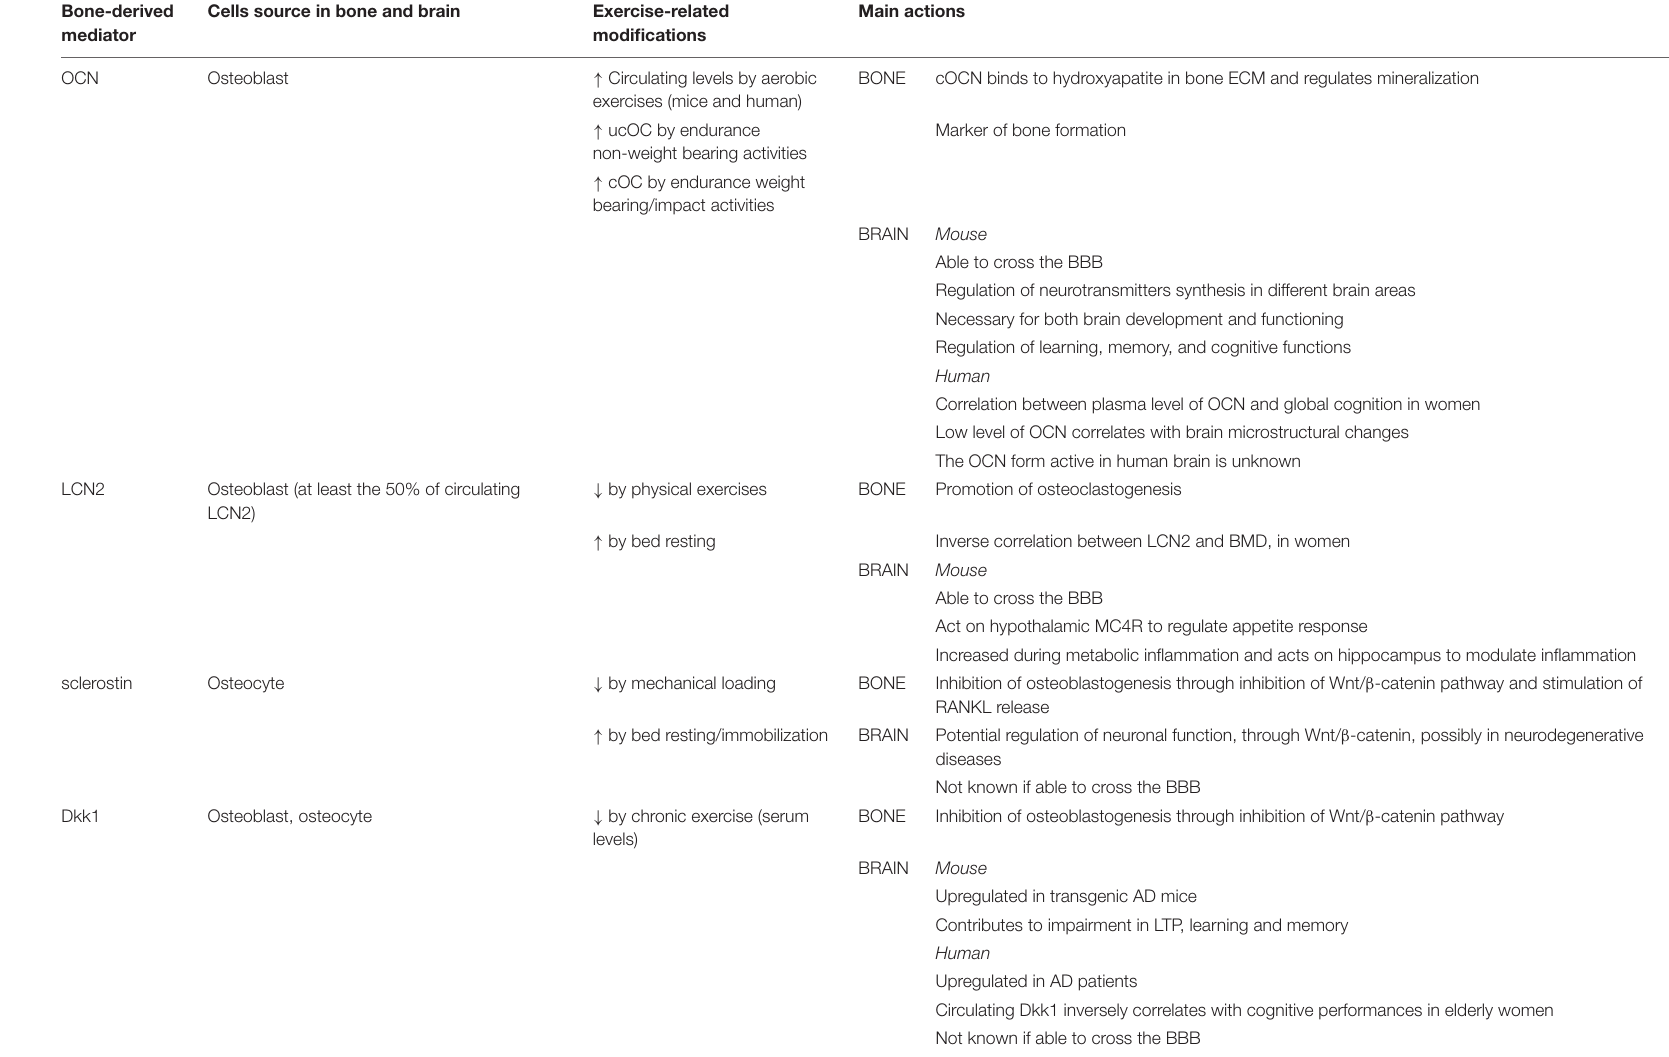
TABLE 5 | Bone to brain communication: hormones and peptides. Bone-derived